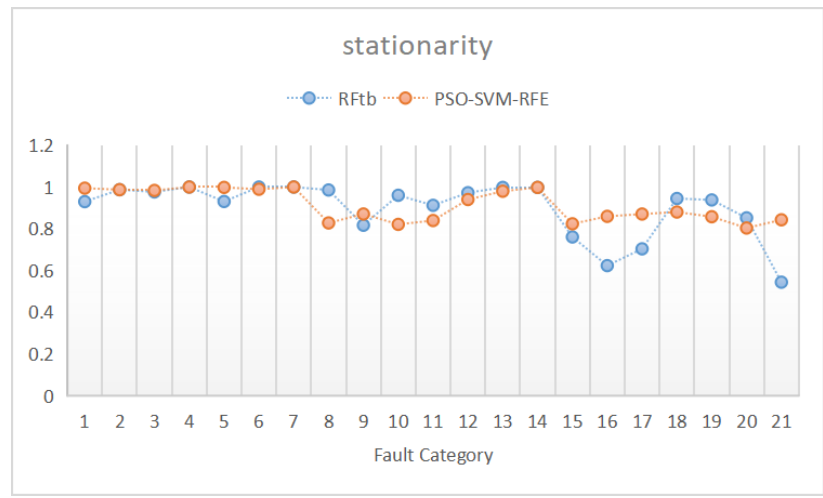
Figure 5. Stability comparison of PSO-SVM-RFE and RFtb for 21 fault diagnosis